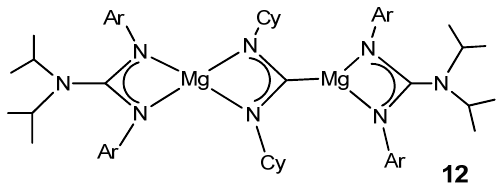
Figure 8. Magnesium magnesioamidinato